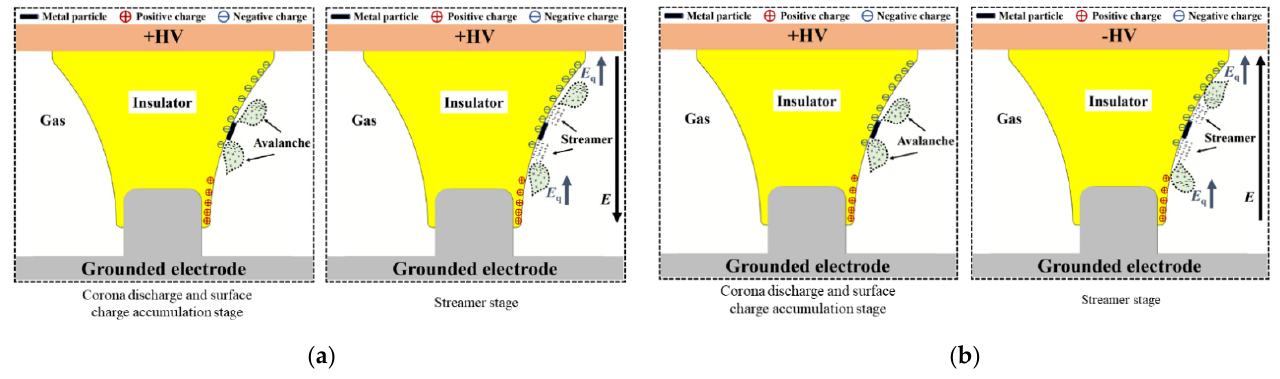
Figure 13. Flashover process of tri–post insulator with attached metal particle under superimposed DC and impulse voltage. ( a ) Positive DC + Positive LI; ( b ) Positive DC + Negative LI.